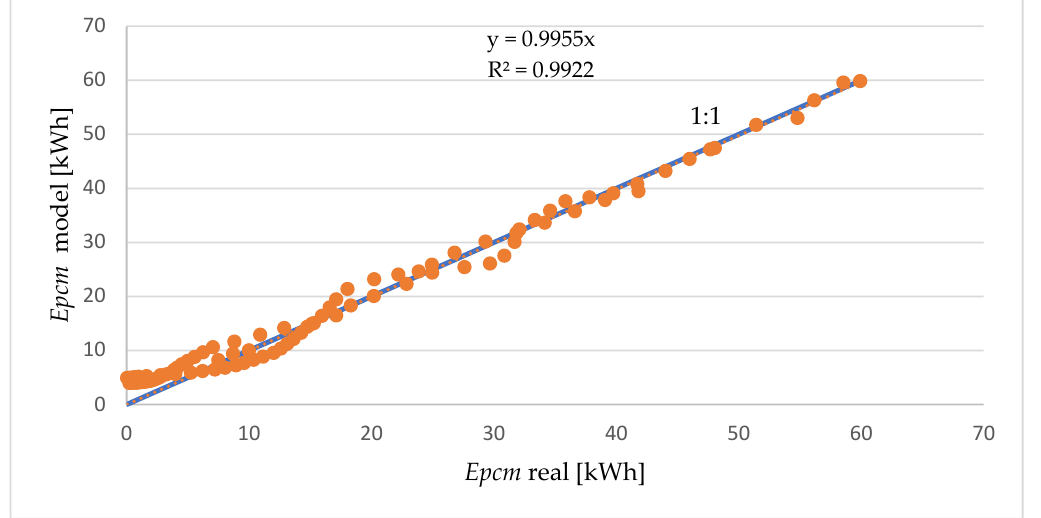
Figure 9. Comparison of the actual and forecast amounts of stored energy in a PCM battery.